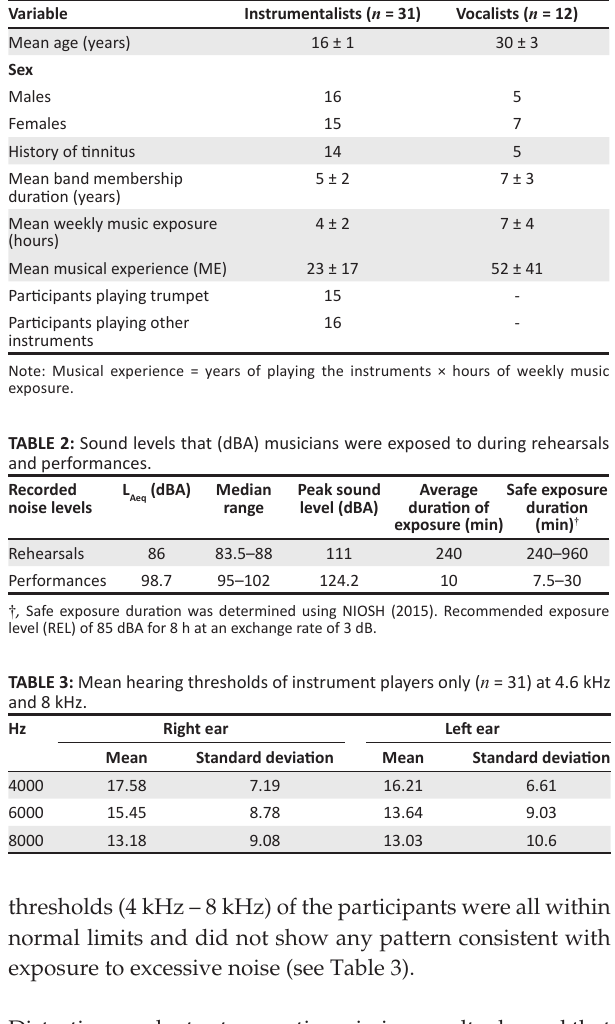
TABLE 1: Participants’ description ( n = 43).